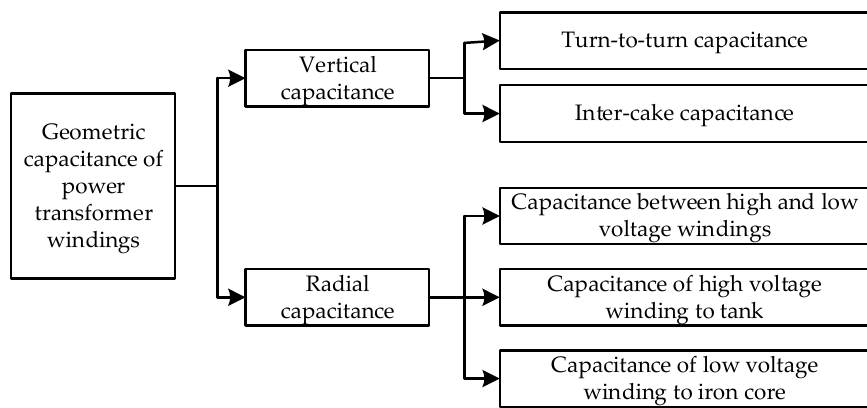
Figure 5. Equivalent capacitance distribution of transformer windings.